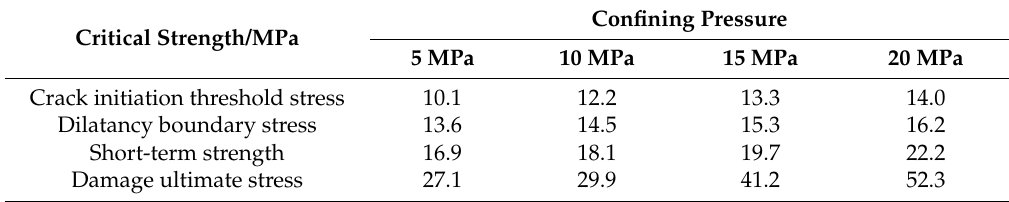
Table 1. Four critical strengths of rock salt under triaxial compression